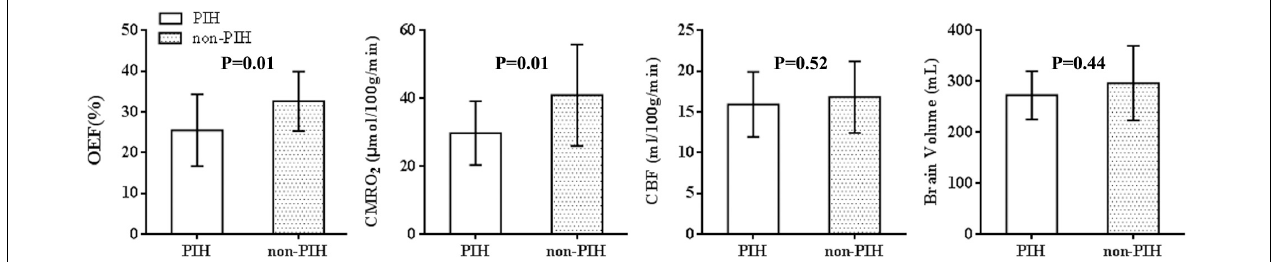
FIGURE 3 | Oxygen extraction fraction-, CMRO 2 -, CBF-, and brain volume-data for 22 control and 16 maternal PIH infants. The mean, SD, minimum and maximum values for the OEF, CMRO 2 , CBF, and brain volume of the two groups were shown; the OEF and CMRO 2 , in PIH group differed significantly from the parameters in control group ( t = –2.7, P = 0.01; t = –2.6, P = 0.01). There was no significant difference between the two groups with regards to CBF ( t = –0.7, P = 0.52) or brain volume ( t = –1.3, P = 0.22).